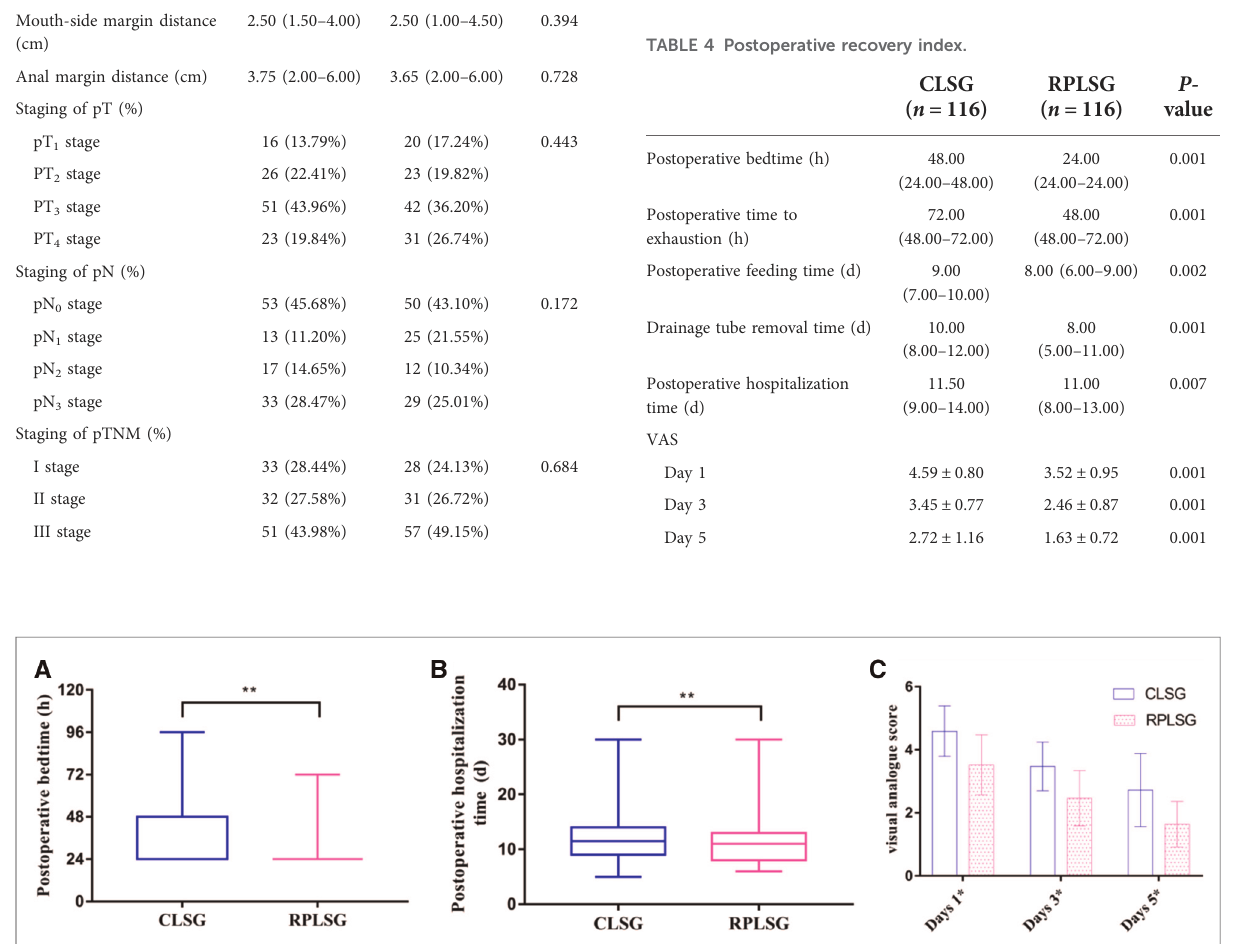
FIGURE 3 ( A ) effect of different surgical methods on postoperative bedtime; ( B ) effect of different surgical methods on postoperative hospitalization time; ( C ) the effect of different surgical methods on postoperative pain on days 1, 3, and 5.